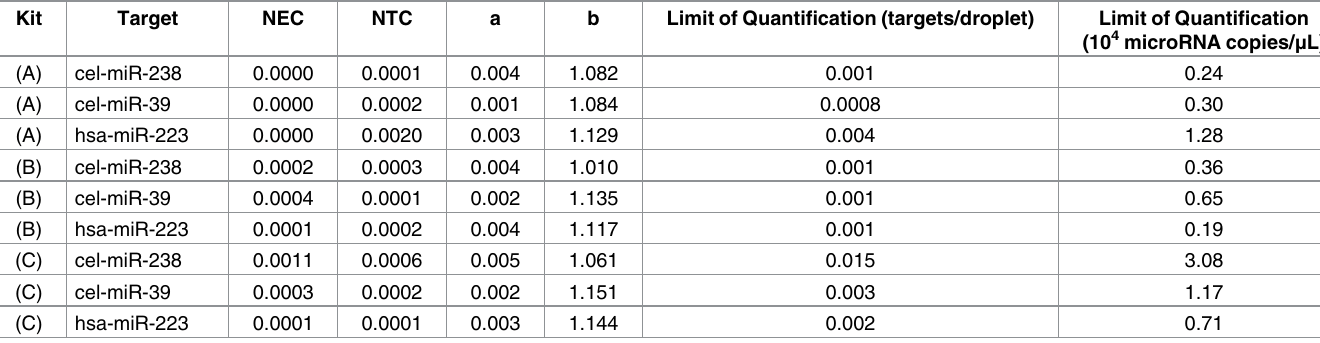
Table 6. Synthetic microRNAoligonucleotide titration for each kit and target.